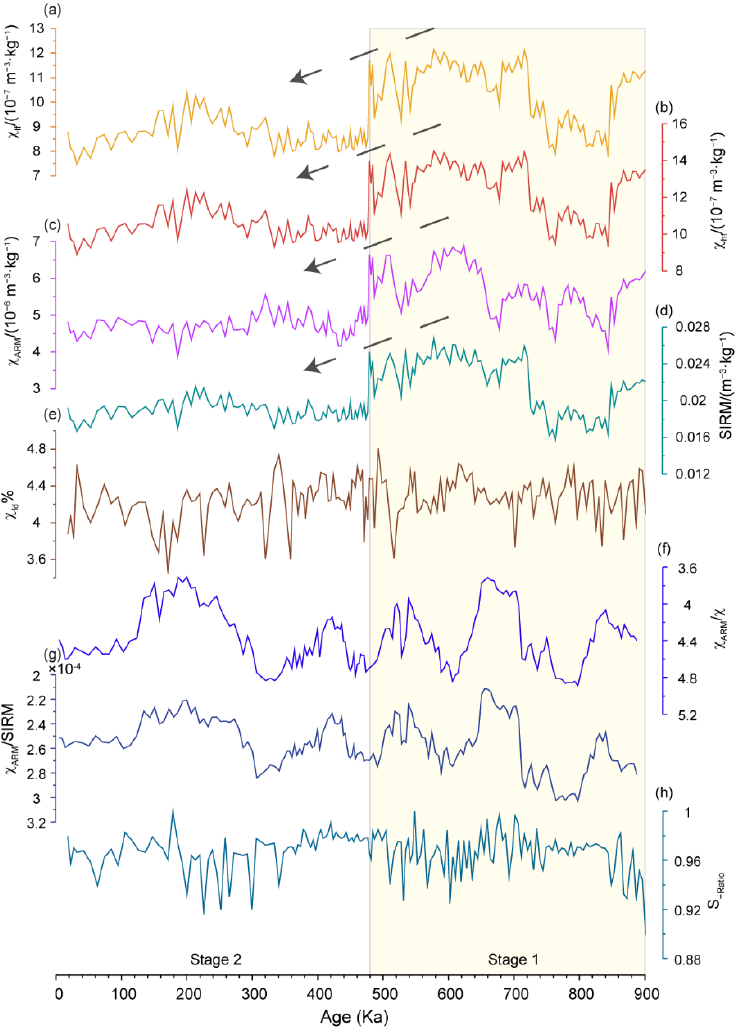
Figure 3. Changes in magnetic parameters of Core I8 since around 900 ka; ( a ), the low-frequency magnetic susceptibility ( χ lf ); ( b ), the high-frequency magnetic susceptibility ( χ hf ); ( c ), the susceptibility of anhysteretic remanent magnetization ( χ ARM ); ( d ), the saturated isothermal remanent magnetization (SIRM); ( e ), the percentage of frequency-dependent susceptibility ( χ fd%); the grain-size-dependent magnetic parameters χ ARM / χ ( f ) and χ ARM /SIRM ( g ); ( h ), the S -ratio . It can be divided into two stages (before and after 480 ka) according to the changes in magnetic parameters.